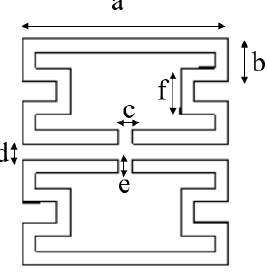
FIGURE. 4. THE UNIT CELL OF THE MOORE FRACTAL APPLIED SYMMETRICAL RING RESONATOR.